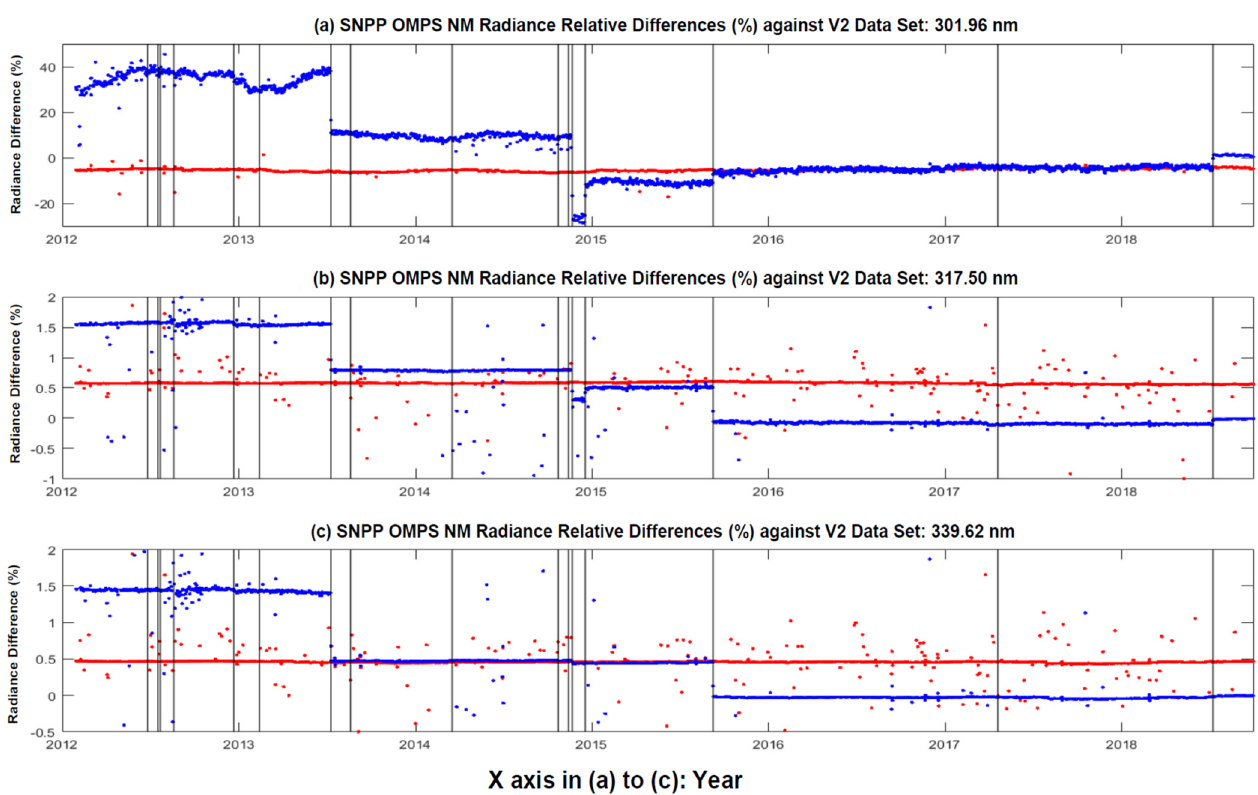
Figure 10. Same as Figure 9 except for the averaged N-value; ( a ) 301.96 nm, ( b ) 317.497 nm, ( c ) 339.622 nm.